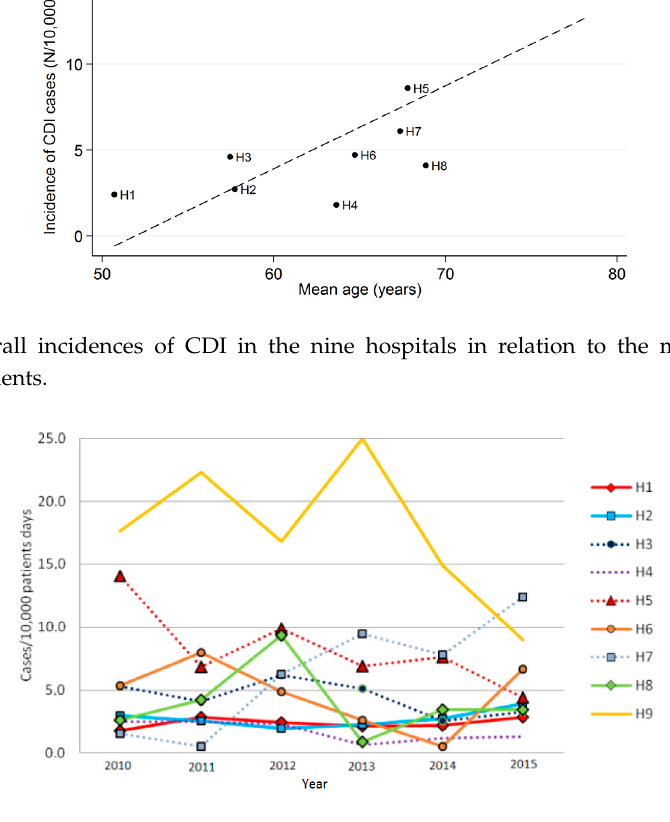
Figure 1. Overall incidences of CDI in the nine hospitals in relation to the mean age of the hospitalized patients.